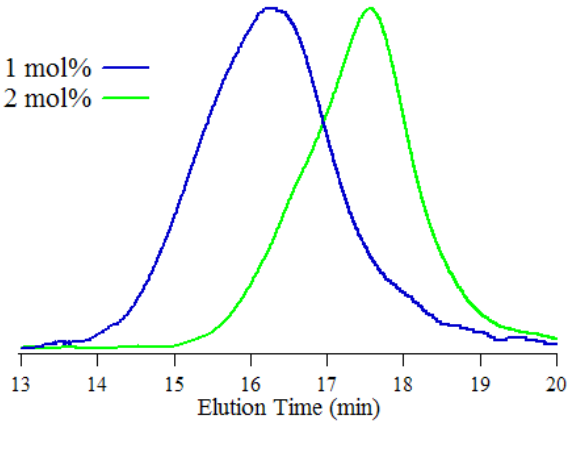
Figure 2. GPC charts of P(3HT- b -3SFT) synthesized by using Ni(dppp)Cl and 2